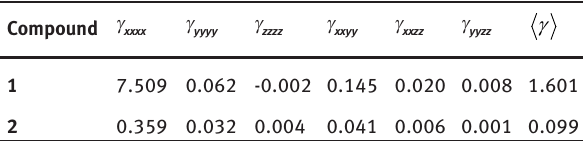
Table 7: Some selected components of the frequency-dependent ),,;3( ωωωωg − and absolute values of ),,;3( ωωωωg − ( × 10 -35 esu) at ω =0.04282 a.u. for 1 - 2 computed by TDHF method with 6-31G( d ) basis set.